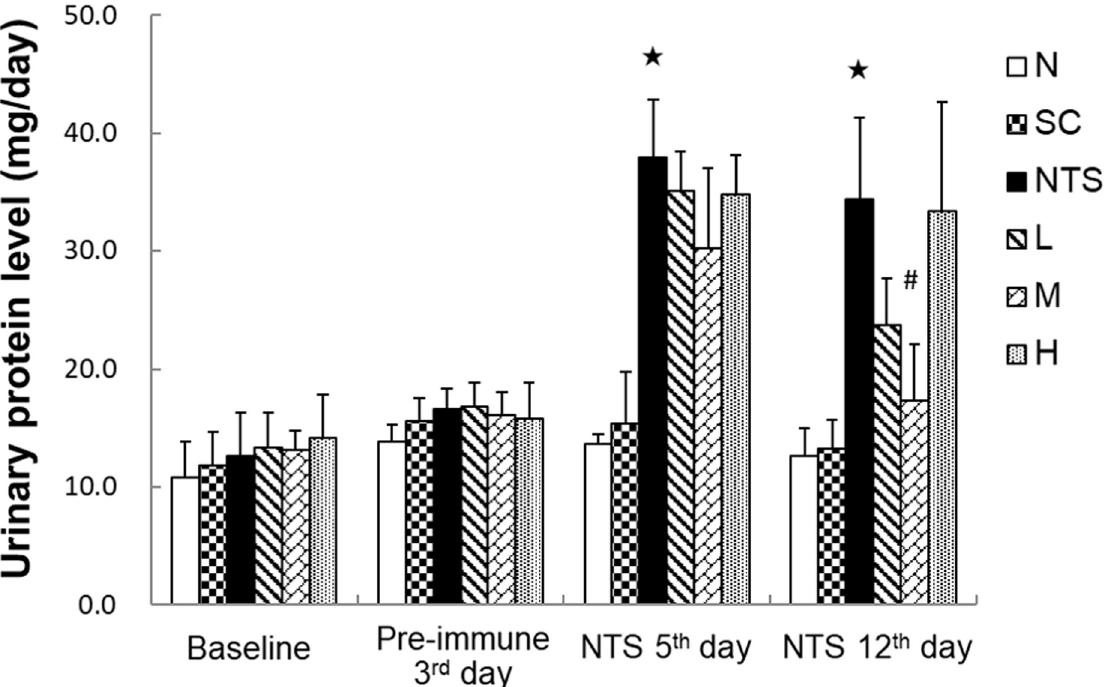
Fig 2. Urinary protein levels of each experimental group. N: normal group, SC: saikosaponin C control group, NTS: nephrotoxic serum control group, L: SSC 5 mg/kg/day treatment group, M: SSC 10 mg/kg/day treatment group, H: SSC 20 mg/kg/day treatment group. $ p < 0.05 compared to N group, # p < 0.05 compared to NTS control group.